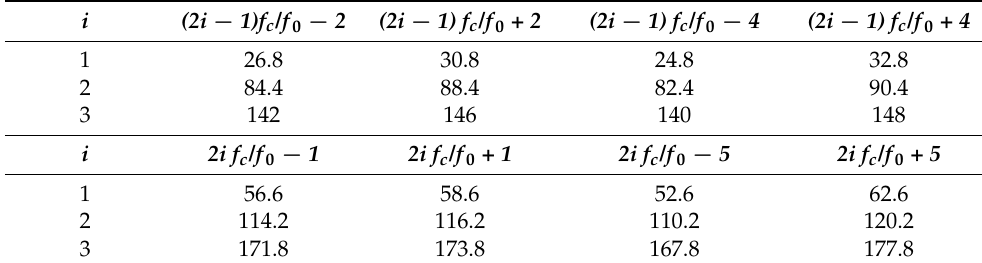
Figure 2. Block diagram for dynamic simulation of the HPMSM. Table 3. Major harmonics order of phase current by PWM.